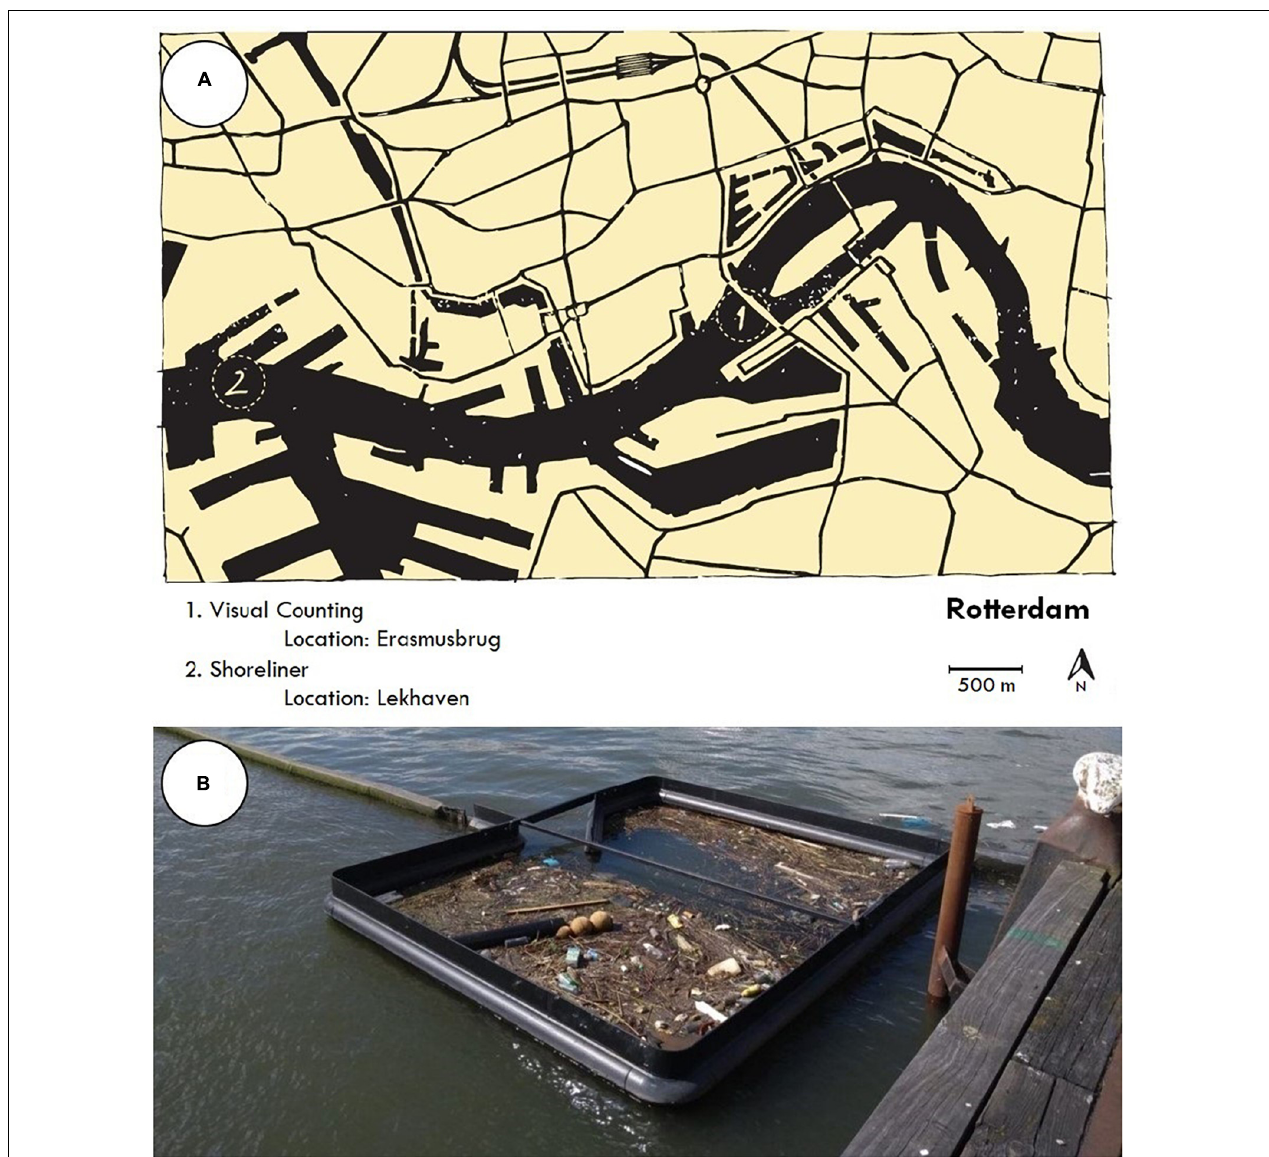
FIGURE 1 | Sampling location and setup, with (A) the measurement locations, with the river mouth located approximately 30 km westwards (Credit: Cher van den Eng) and (B) a photo of the Shoreliner located in the Lekhaven, with the collection boom leading to the collection eye via a non-return valve (Credit: Tauw).